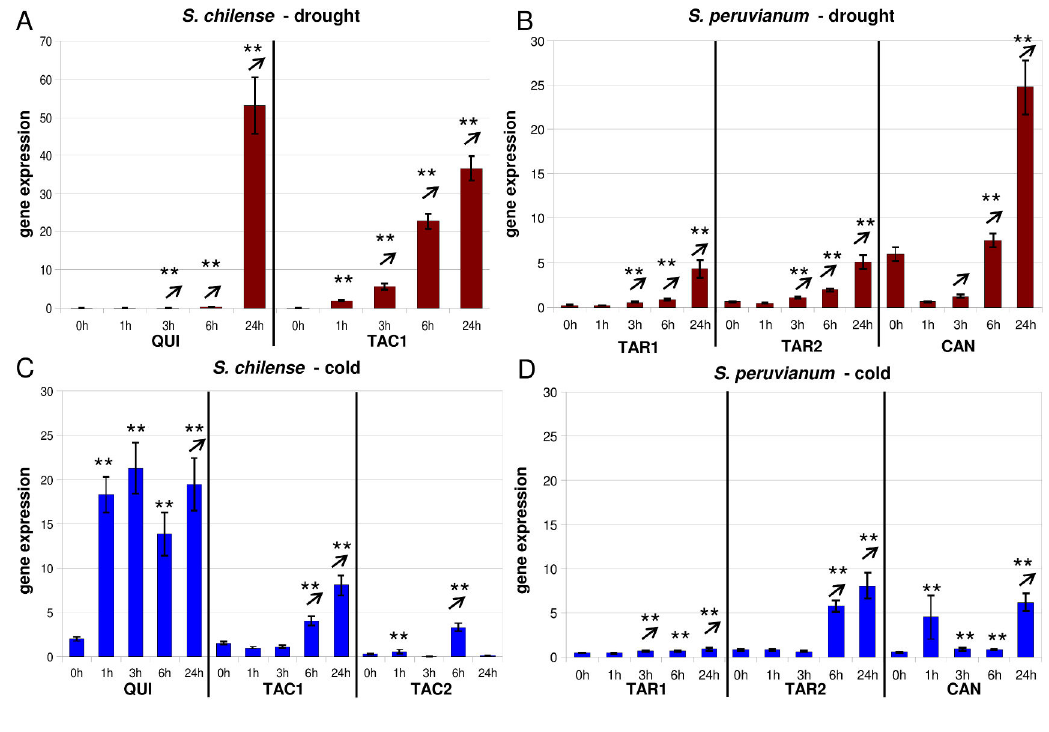
Figure 1. Gene expression of Asr1 after application of drought and cold stress. Expression is displayed relative to the average of the whole qPCR run in unstressed plants, 1h, 3h, 6h, and 24h after stress application. (A) The following accessions of S . chilense were measured after drought stress (red bars): LA1938 (QUI) from a dry environment and LA1967 (TAC) from a hyperarid area. (C) The following accessions of S . chilense were measured after cold stress (blue bars): LA1938 (QUI) from a dry environment and LA1967 (TAC1) from a hyperarid area and LA1969 (TAC2) from a very dry environment and high altitude. The following accessions of S . peruvianum were measured after (B) drought (red bars) and (D) cold stress (blue bars): LA2744 (TAR1) and LA2745 (TAR2) from a dry environment and LA3636 (CAN) from a humid environment. Vertical lines at bar charts indicate the standard error, asterisks above bar charts indicate significant over-expression compared to the unstressed control ( * P <0.05; ** P <0.01), arrows above bar charts indicate significant over-expression ( P <0.01) compared to the previous timepoint – meaning the transcript level is